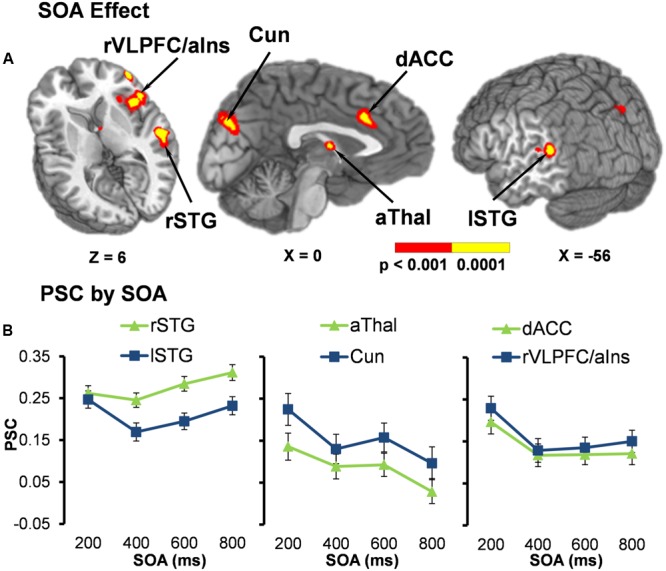
(A) Displays the regions of the brain showing a significant main effect of stimulus onset asynchrony (SOA) (p < 0.001: red; p < 0.0001: yellow). Locations of the sagittal (X) and axial (Z) slices are given according to the Talairach atlas. (B) Displays the average percent signal change (PSC) for each significant region and at each SOA (200, 400, 600, and 800 ms), separated into three graphs for each pattern of activation found. The first pattern showed the right (rSTG) and left (lSTG) superior temporal gyrus decreasing in activation from 200 ms to 400 ms SOA trials, followed by increased activation as a function of increasing SOA. Second, activation within the anterior thalamus (aThal) and bilateral cuneus/precuneus (Cun) generally decreased as a function of SOA. Finally, activation in the dorsal anterior cingulate gyrus (dACC) and right ventrolateral prefrontal cortex/anterior insula (rVLPFC/aIns) was at its highest during 200 ms SOA and then remained constant across all other SOAs. Error bars represent the standard error of the mean.